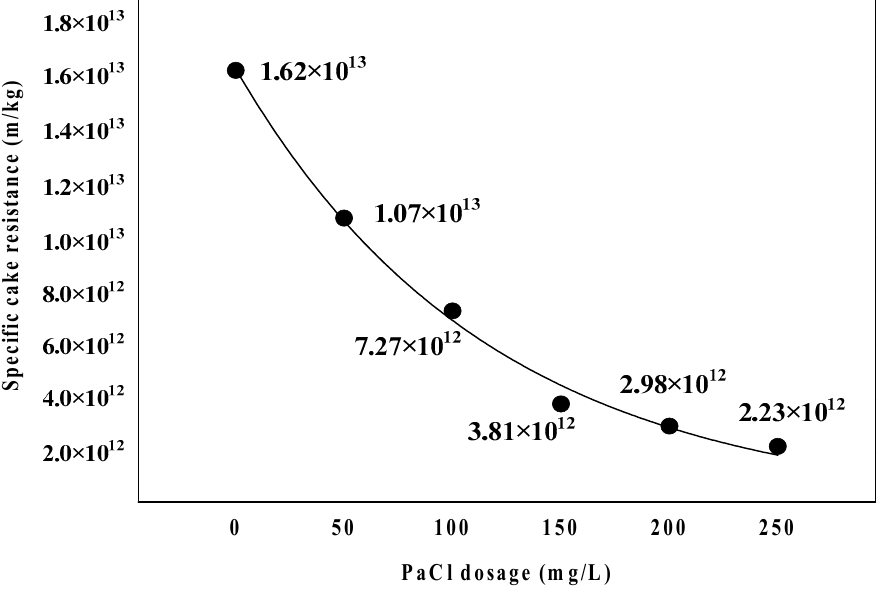
Figure 5. Comparison of cake specific cake resistance with coagulant dosage.